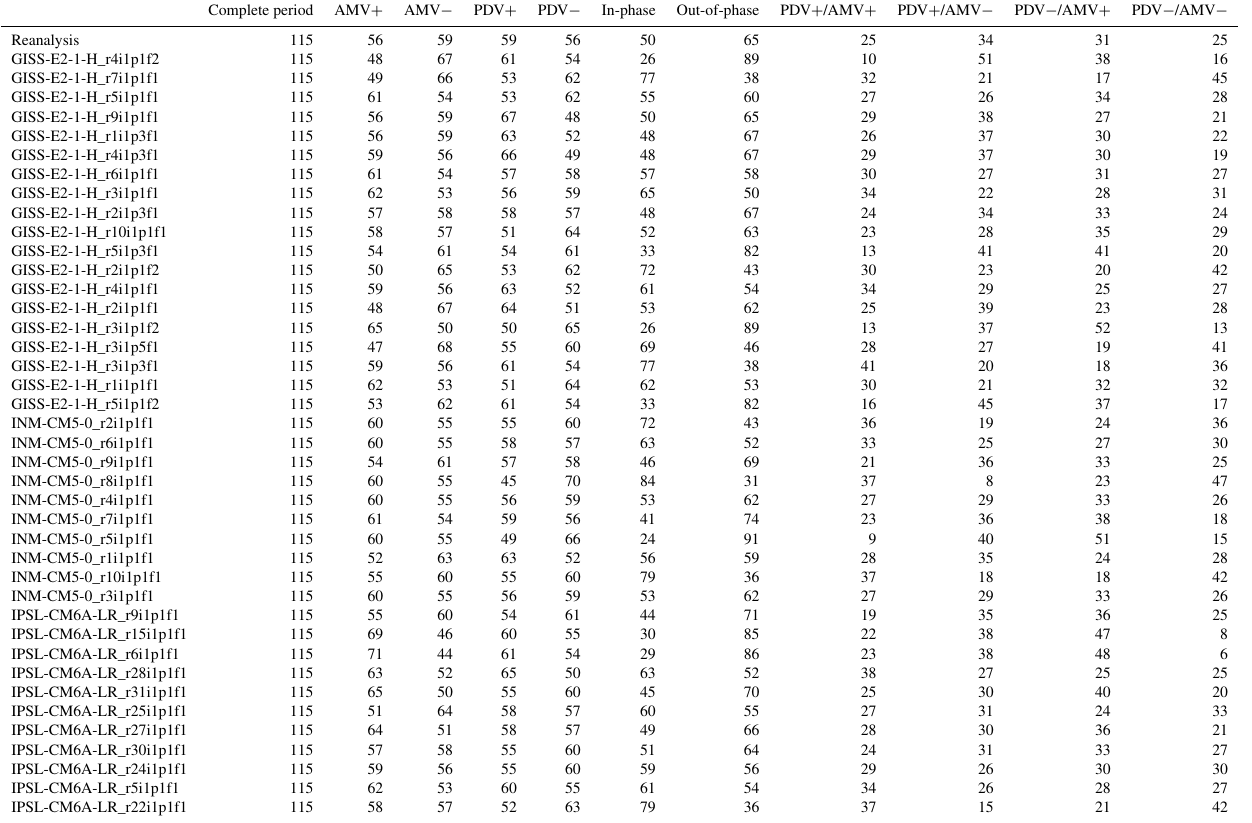
Table A7. Number of years for every regime for reanalysis and CMIP6 simulations